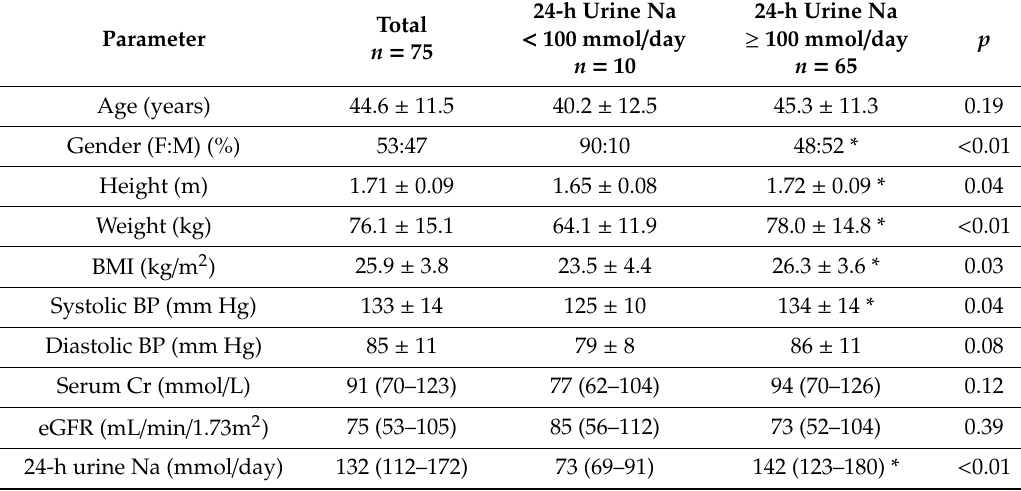
Figure 1. Flow diagram showing the number of participants recruited, excluded and included in the study. Abbreviation: SSQ, scored salt questionnaire. Table 1. Clinical characteristics of the high and low sodium intake groups in the study